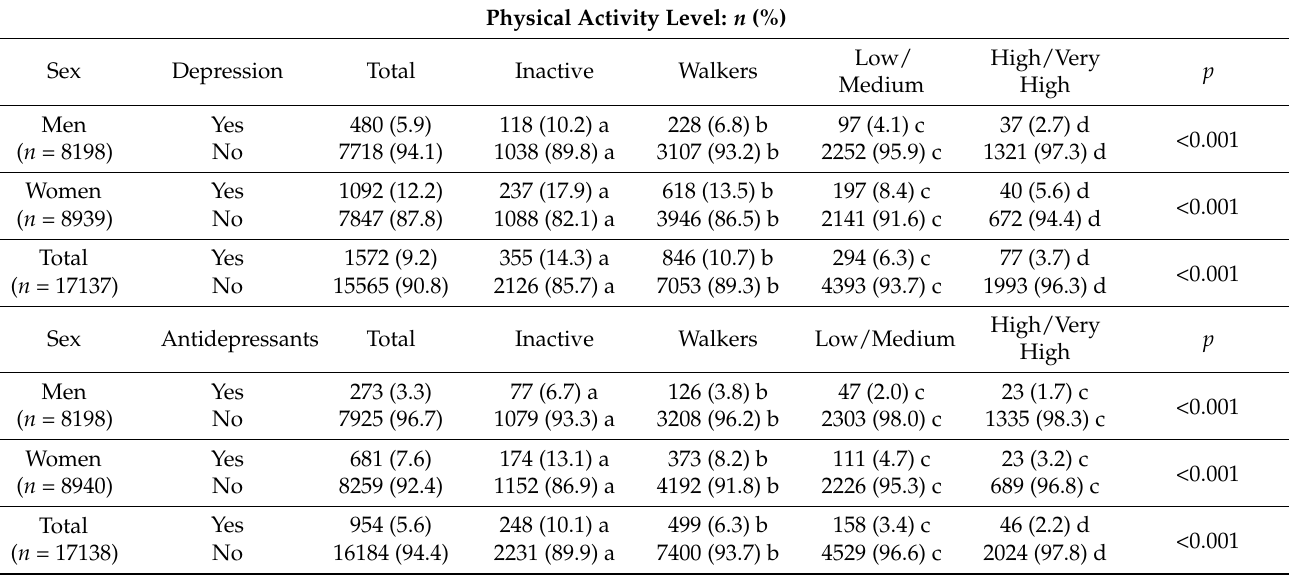
Table 4. Relationship between the prevalence of antidepressants and the level of physical activity in the general Spanish population of the ENSE 2017 aged between 18 and 69 years, and by sex. Physical Activity Level: n